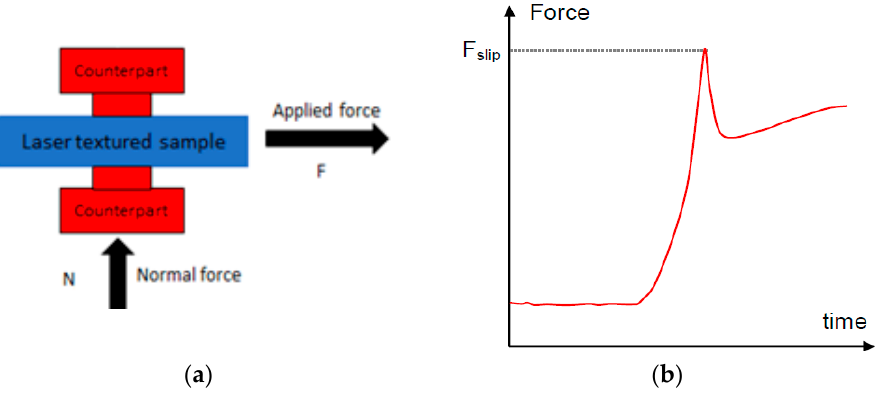
Figure 4. ( a ) Schematic of the static friction coefficient testing setup. ( b ) Typical plot of force as a function of time during the test.